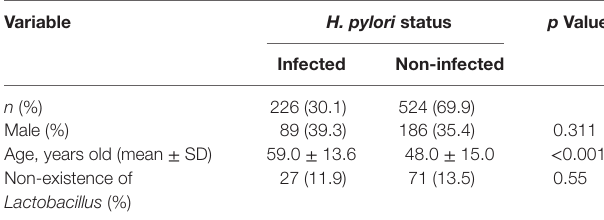
TaBle 1 | Subject characteristics according to Helicobacter pylori